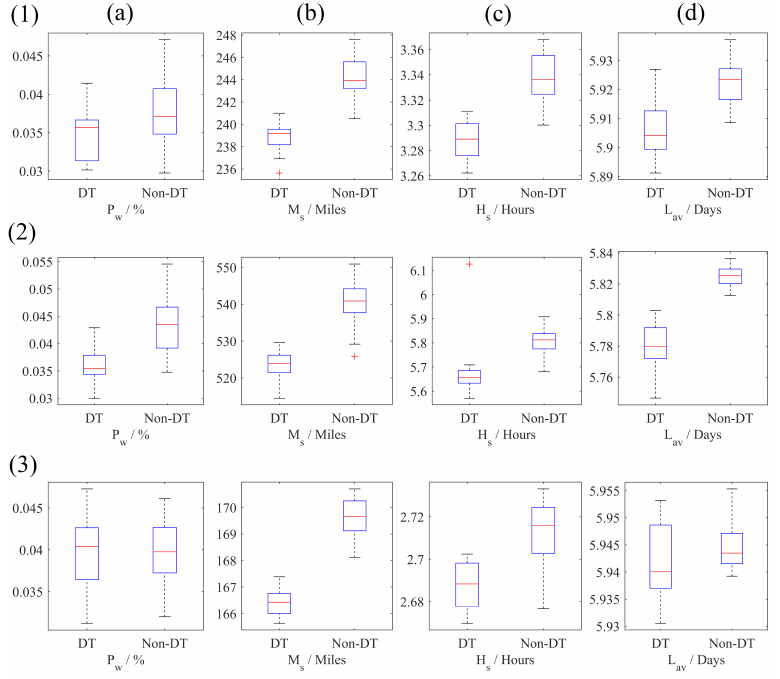
Figure 8. Box plots representing the distribution of performance metrics P w , M s , H s , and L av ( a , b , c , and d , respectively) for scenarios 1, 2, and 3. The largest disparity between digitalised and non- digitalised runs is seen for scenario 2, indicating that it is more likely to benefit from increased sensorisation. Here, DT represents digitalised. Note that axis labels follow the format performance metric/unit. For example, H s /Hours is the time spent waiting for a delivery by Customers measured in